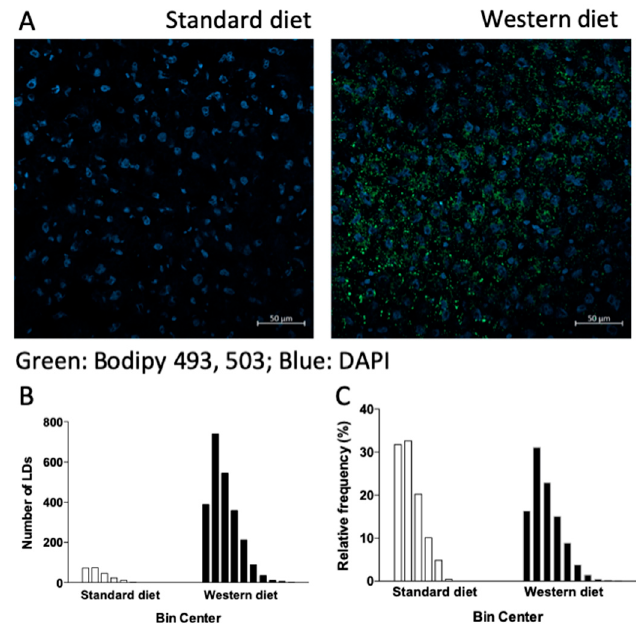
Figure 2. Lipid droplets (LDs) in rat livers. Staining with Bodipy 493/503, a marker of lipid droplets. Cell nuclei are stained blue with 4 ′ ,6-diamidino-2-phenylindole (DAPI). ( A ). Absolute number of the different classes of LDs according to their diameter (observed range: 0.4–2.4 μ m and 0.4–4 μ m for rats fed with standard and Western diet, respectively) ( B ), and their relative frequencies ( C ).